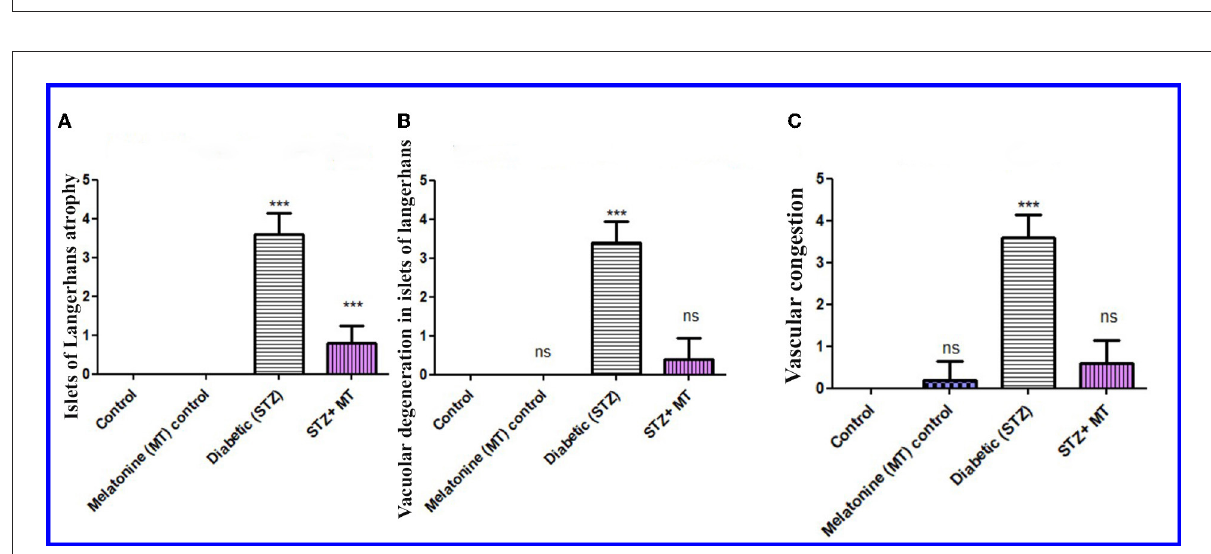
FIGURE6 Histomorphometry graph showing semiquantitative measurements of pancreatic tissue sections among the experimental groups. (A) Atrophy of the islets of Langerhans, (B) Vacuolar degeneration in the islets of Langerhans, and (C) Vascular congestion. Values are expressed as means ± SD. Significant differences vs. the control group are marked by different asterisks through one-way ANOVA with Tukey’s post hoc test: ns, non-significant; *** P ≤ 0.001.